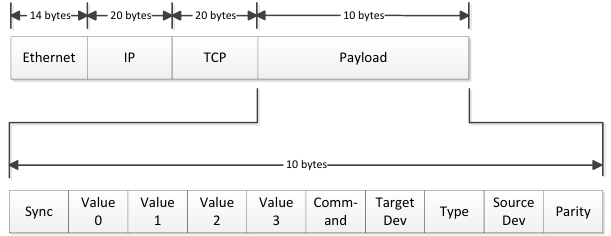
Figure 6. Structure of a GLORIA telecommand data packet encap- sulated in a TCP/IP frame. The synchronisation byte is followed by four optional-value bytes and by the command byte, indicating which action to take. In addition, the target device as well as the source device are included in the packet. The type byte indicates how the four value bytes should be interpreted as shown in Table 2.